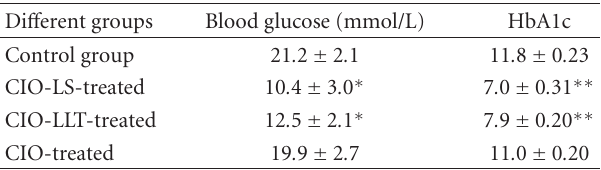
Table 4: E ff ect of CIO, CIO-LS and CIO-LLT on blood glucose and HbA1c levels in alloxan-hyperglycemic rats.